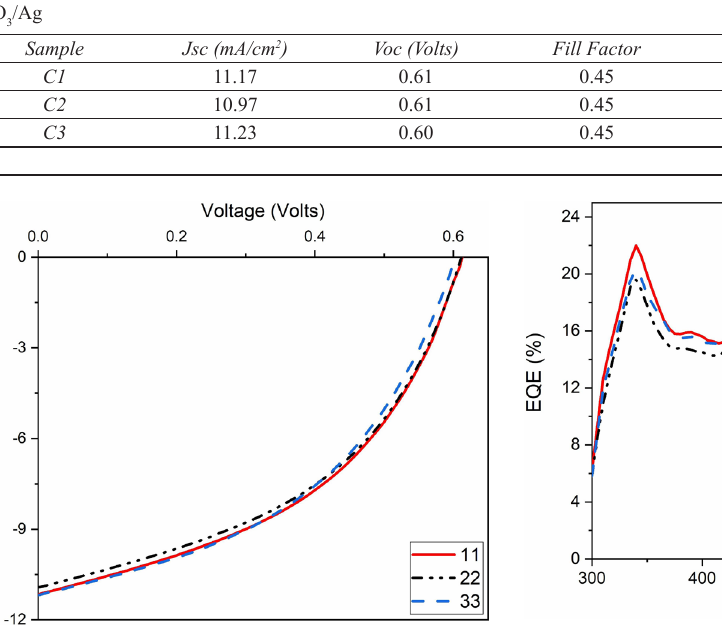
/P3HT:PC BM/MoO 2 61 3